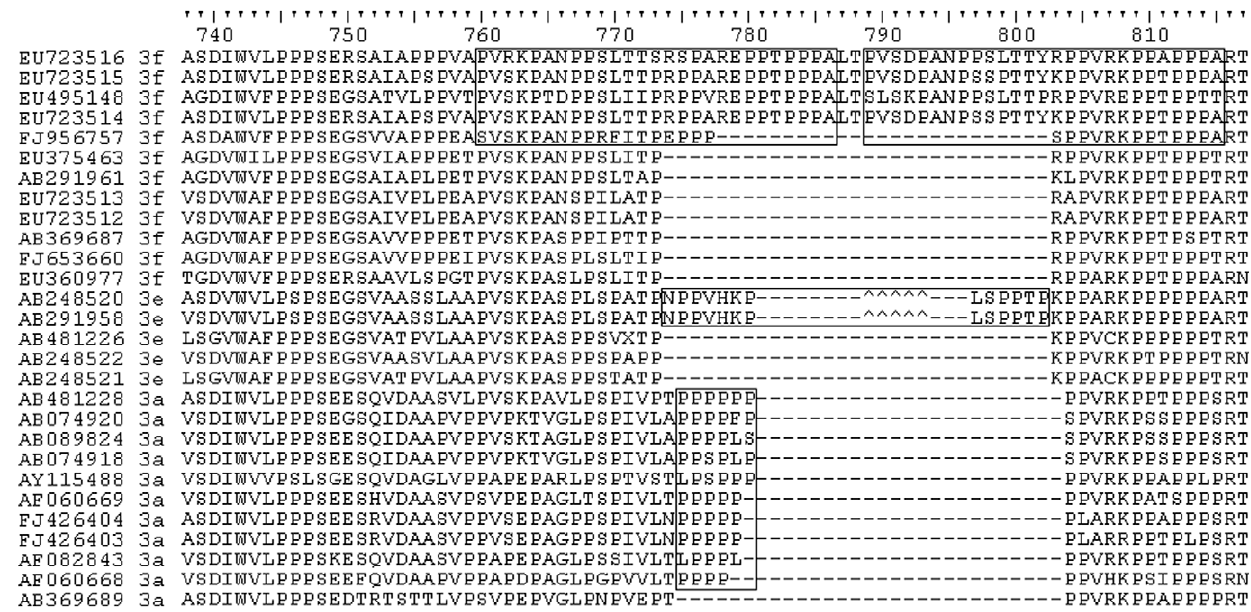
Figure 6. Sequence duplications in genotype 3. Selected genotype 3 PPR sequences were aligned against EU723516. Each sequence is identified by its GenBank accession number and subtype. Boxes show sequence duplications for 3f and insertions for 3e and 3a sequences. Carets identify an alternative alignment region for the PVHKP peptide (positions 776–780) for genotype 3e.